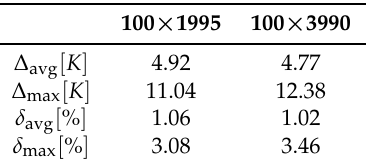
Table 2. Errors of temperature reconstruction in measurement point x p = 3.825 for grids 100 × 1995 error, δ max —maximal relative error).